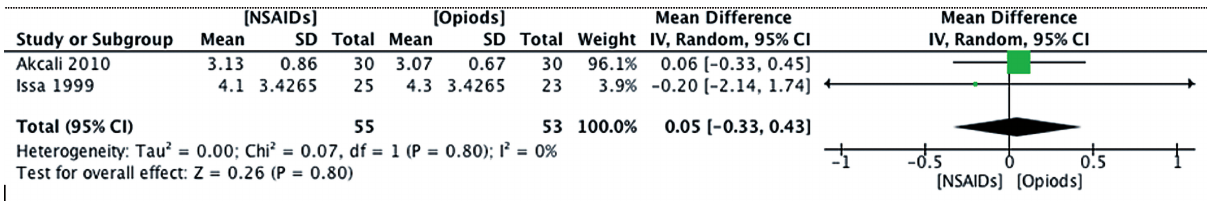
figure 3 - comparison between nsAIDs and opioids, post-op visual analogue